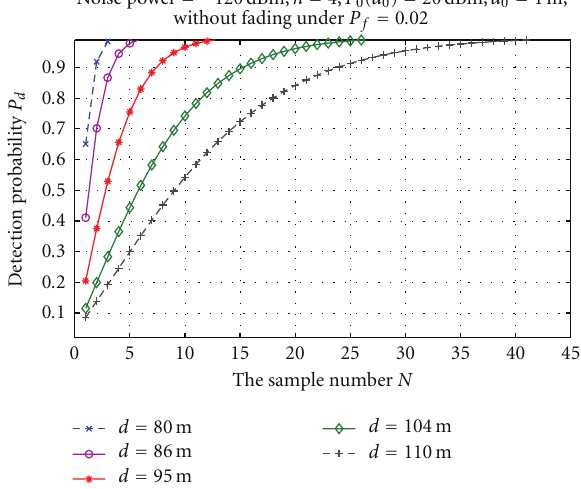
Figure 2: Traditional NP method: under fixed P f ,NP = 0 .